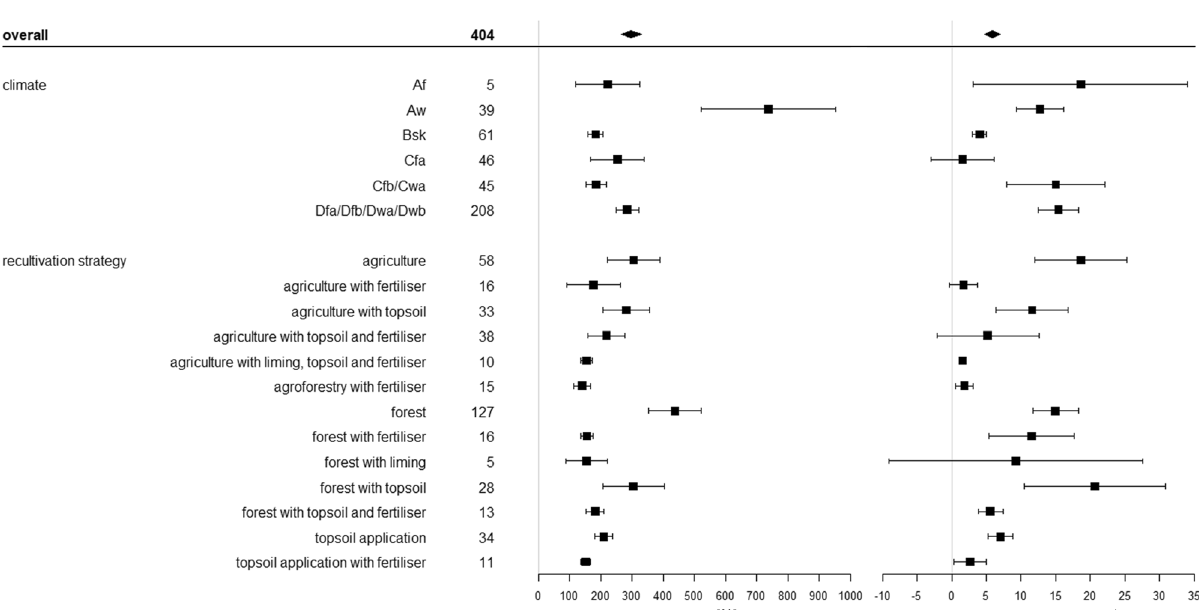
Figure 5. Relative response of soil organic carbon stocks [%] and absolute difference in soil organic carbon stocks [Mg ha −1 ] influenced by thirteen different recultivation strategies and climate. The climate is classified according to Koeppen–Geiger (Af = tropical rainforest/equatorial climate; Aw = tropical savanna or tropical wet and dry climate; Bsk = semi-arid/semi-desert/steppe climate; Cfa = humid subtropical climate; Cfb/ Cwa = oceanic/maritime/marine climate; Dfa/Dfb/Dwa/Dwb = humid continental climate). The overall grand mean of all individual strategies is presented in the first row, whereas the values below correspond to the individual categories. Each response ratio is presented as the mean with the upper and lower 95% confidence intervals. The confidence interval of the grand mean is visualised by the solid square. The number in each strategy row expresses on how many pairwise comparisons the statistics were